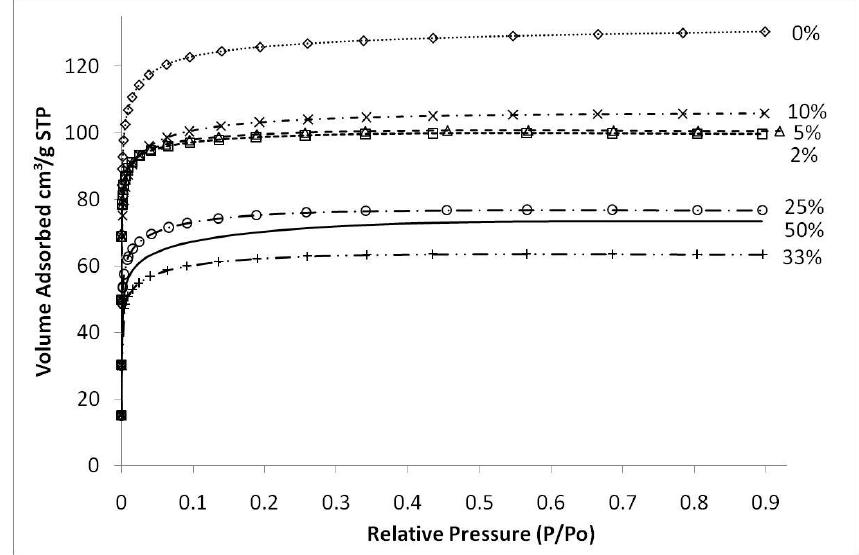
Figure 4. Nitrogen sorption isotherms of samples with varying Fe/Si molar ratio for sample calcined 500